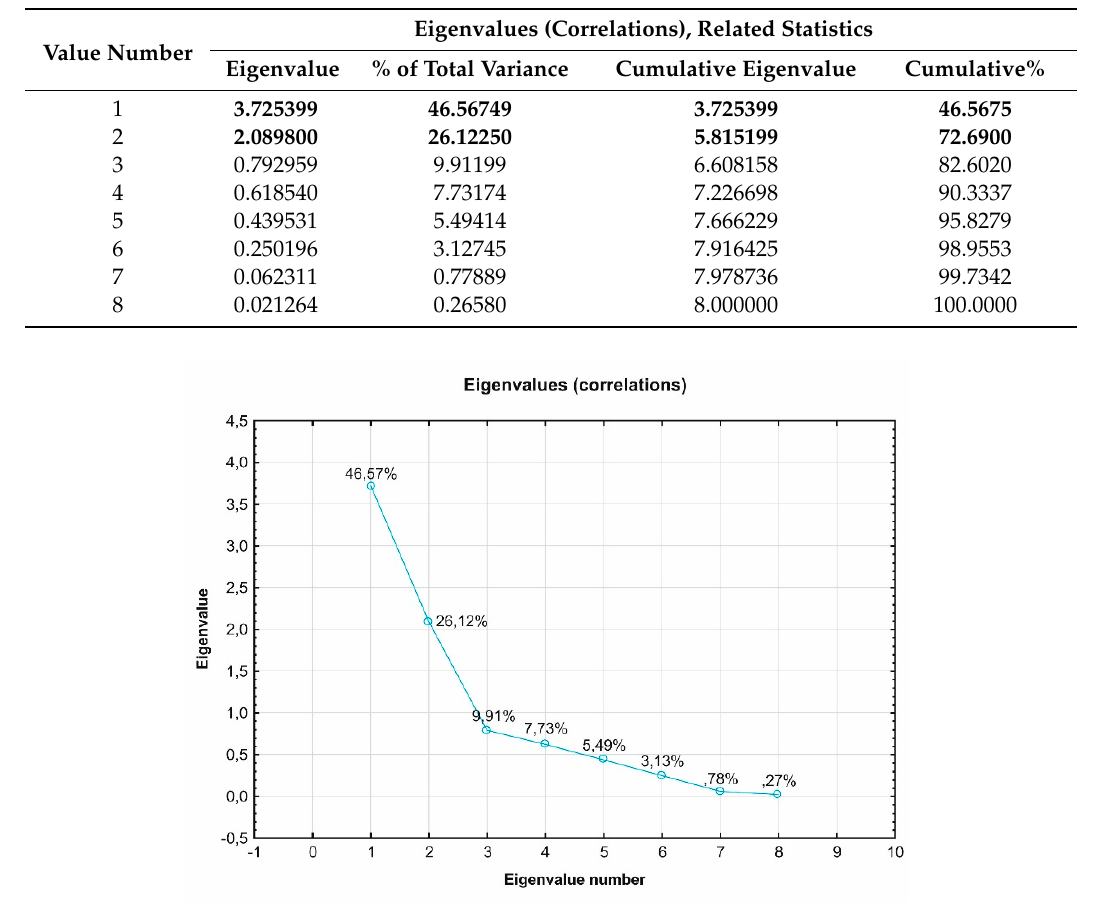
Figure 2. Scree plot for individual values of the matrix of correlation.